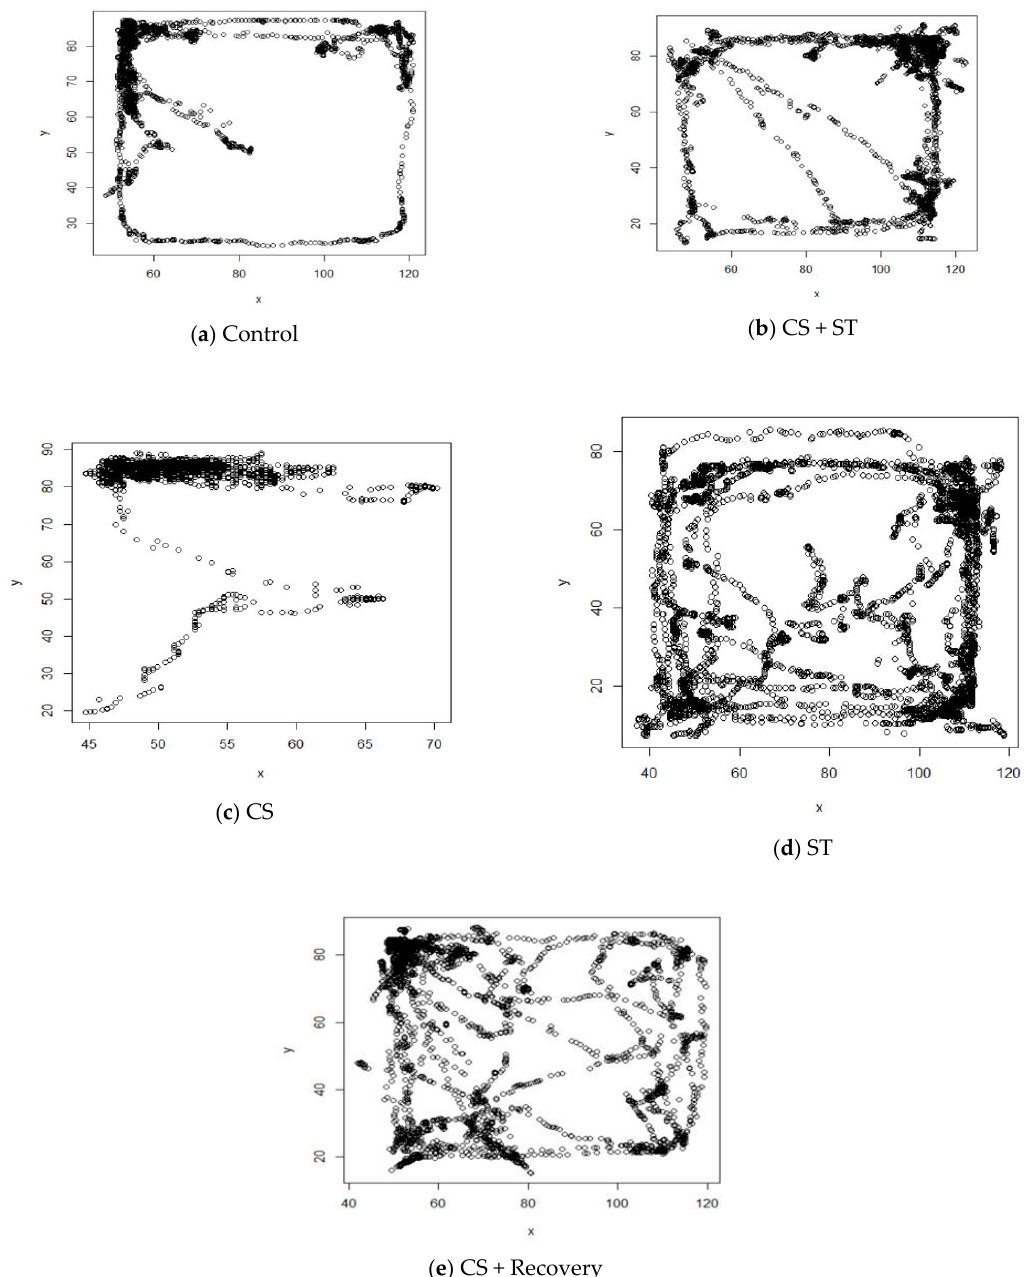
Figure 4. Schematic images of open field testing. (a) Control; (b) CS + ST: chronic mild stress followed by swimming training; (c) CS: chronic mild stress; (d) ST: swimming training; (e) CS + Recovery: chronic mild stress followed by recovery time, CON: control. chronic mild stress followed by recovery time, CON: